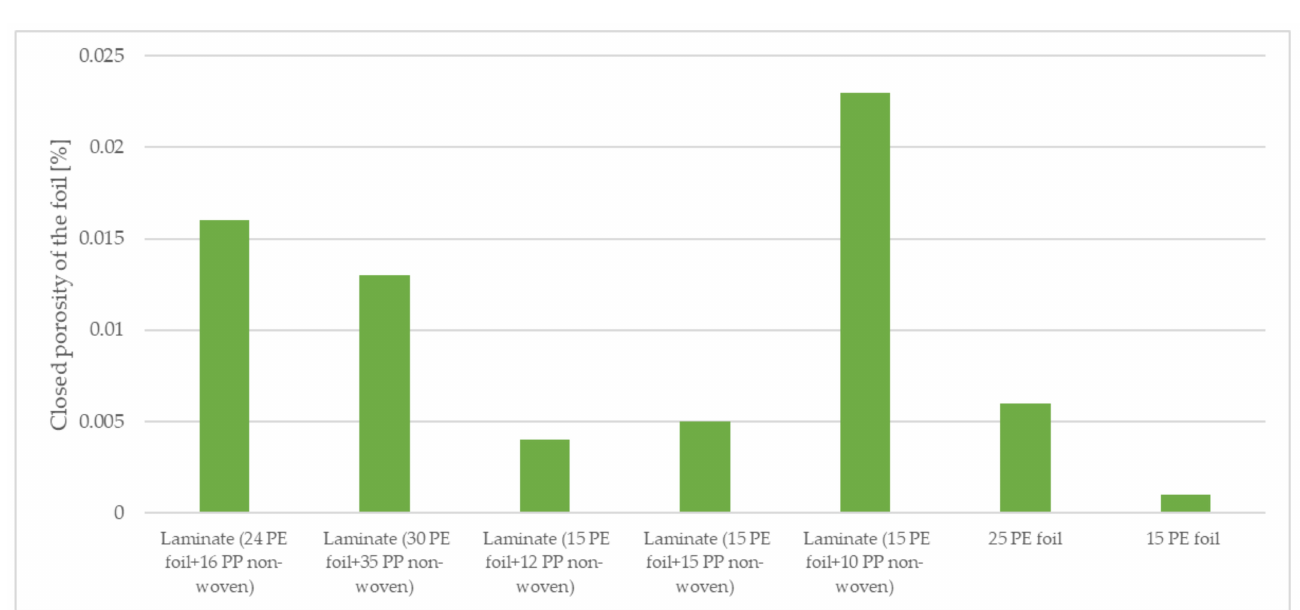
Figure 7. Closed porosity of the materials